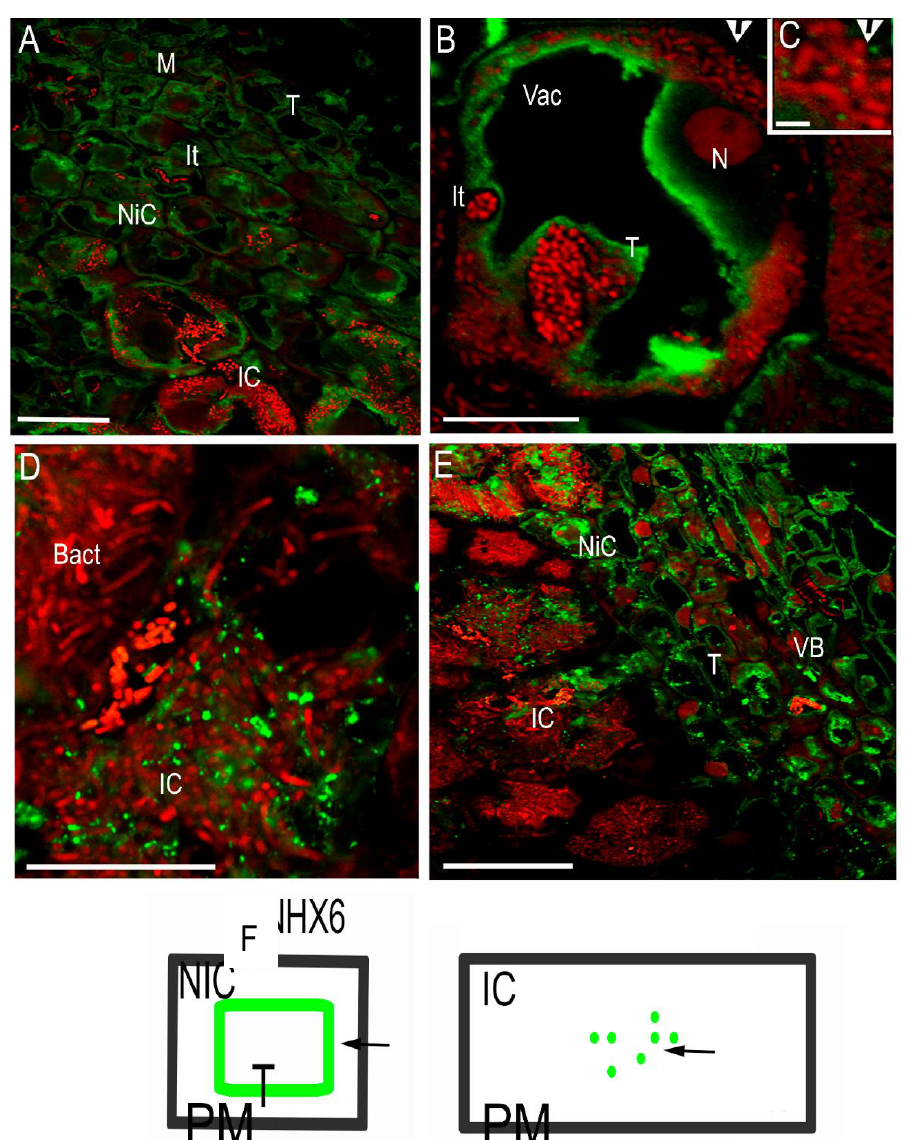
Figure 2. MtNHX6 (green fluorescence) was visualized by using a specific custom-made antibody in wt nodules. Color code: red fluorescence—propidium iodide counterstained bacteria and nuclei, green fluorescence—protein, labeling. For the immunolocalization of MtNHX6, an antibody devel- oped in rabbit and a secondary antibody developed in goat were used. ( A ) In the meristem and distal infection zone, the signal is present over the cytoplasm and tonoplast of young vacuoles in non-infected and freshly infected cells. ( B ) Freshly infected young cell, note the strong signal on the tonoplast, and the small dots in the cytoplasm (arrowhead). ( C ) High magnification of a fraction of ( B ). The signal is in small dots, early endosomes. (D) (The mature infected cells are filled with sym- biosomes with the signal represented as big dots. ( E ) The vascular bundle with the labeling over the tonoplast; note the infected cells with dot-like pattern of labeling. ( F ) The scheme of NHX6 protein distribution as per immunosignal (in green color) to explain the pattern and its changes in infected and non-infected cells. Bact: bacteroid, IC: infected cell, NiC: non-infected cell, M: meristem, It: in- fection thread, VB: vascular bundle, N: nucleus, T: tonoplast. Arrowhead: signal over the plasma membrane (PM). Bars: ( A , E ): 25 μm ; ( B ): 12.5 μm ; ( C ): 1.1 μm ; ( D ): 10 μm .